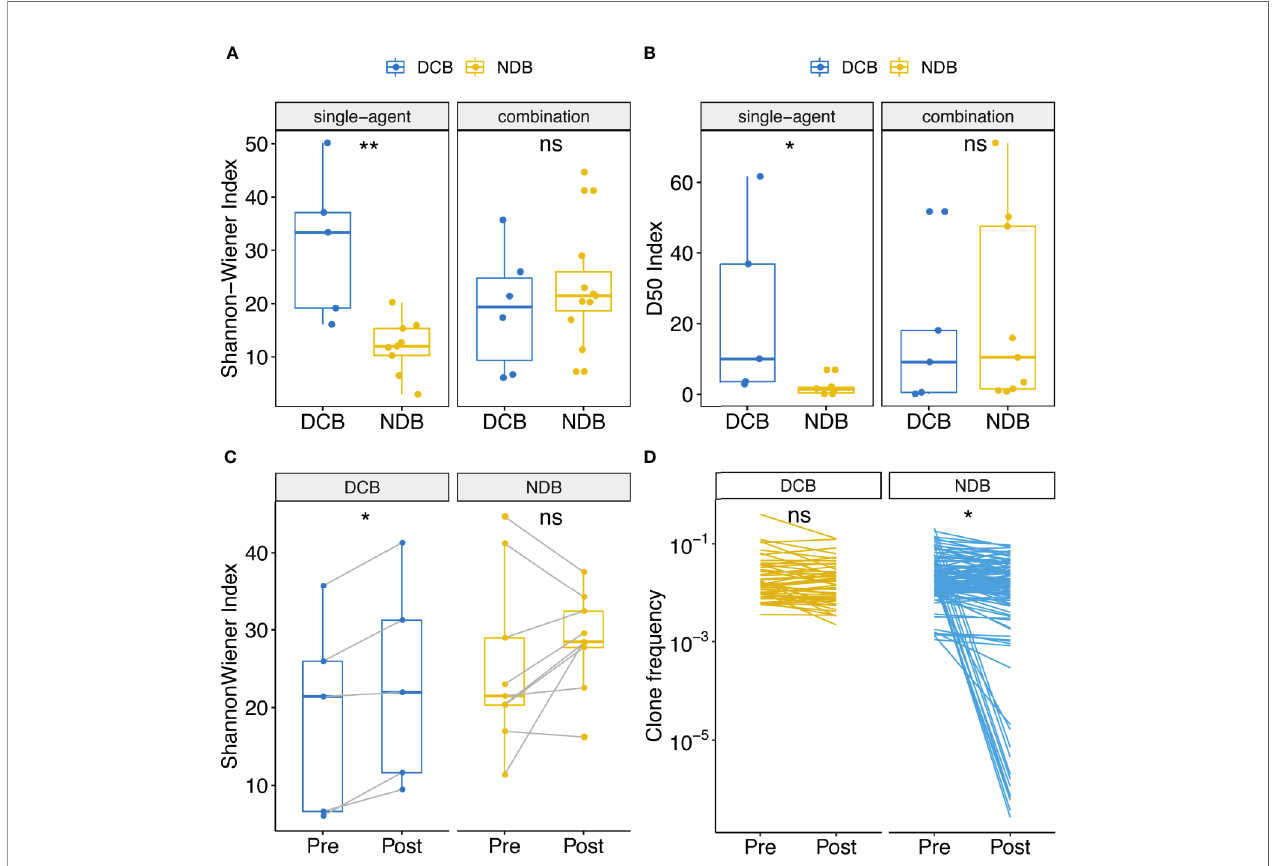
FIGURE 1 | Comparison of diversity of TCR repertoire at baseline between clinical bene fi t and non-clinical bene fi t patients with advanced tumors treated with anti- PD-1/PD-L1 and dynamic change of TCR repertoire at pre- and post-treatment samples correlated with clinical bene fi t. Shannon-Wiener and D50 index diversity were compared between clinical bene fi t (blue points) and non-clinical bene fi t (yellow points) patients. Statistical analysis was performed using the Mann-Whitney test. Boxes depict the interquartile range with the line in boxes showing the median, and the lines outside the boxes showing the fi rst or third quartiles of fraction. ns p >= 0.05, *p < 0.05, **p < 0.01. (A) Shannon-Wiener index distribution in single-agent patients and combination patients. (B) D50 index distribution in single-agent patients and combination patients. (C) Dynamic change of Shannon-Wiener index distribution in patients treated with combination. (D) Clonotype frequencies that exist at 0.1% at baseline for clinical bene fi t and non-clinical bene fi t